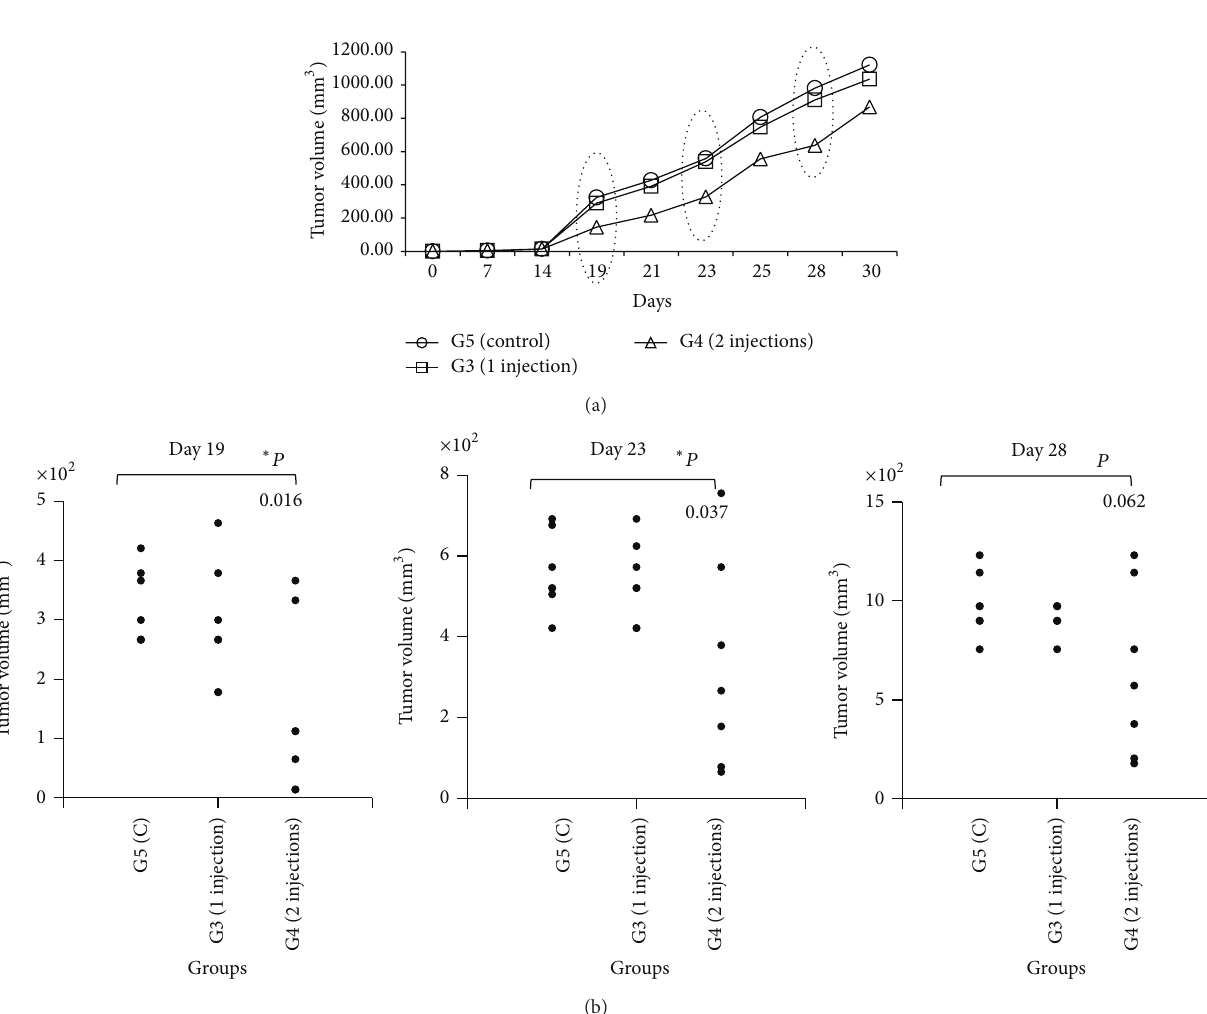
tumor. It has been suggested that other proangiogenic factors such as placental growth factor (PlGF) could also participate in tumor-induced immunosuppression